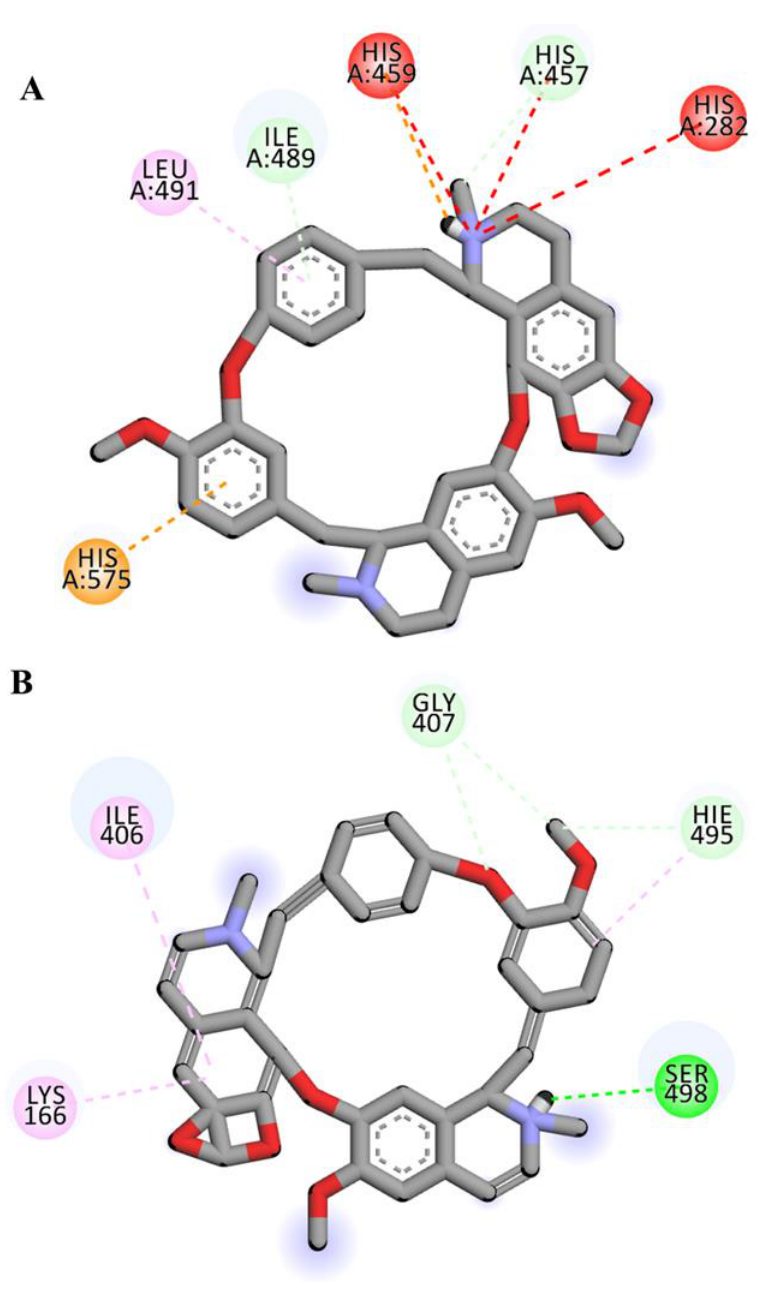
Figure 10. 2D representation of complex-1 before ( A ) and after ( B ) the simulation run of 100 ns. The ligand has been colored by element where grey represents carbon atoms, red corresponds to oxygen atoms and purple shows nitrogen atoms.